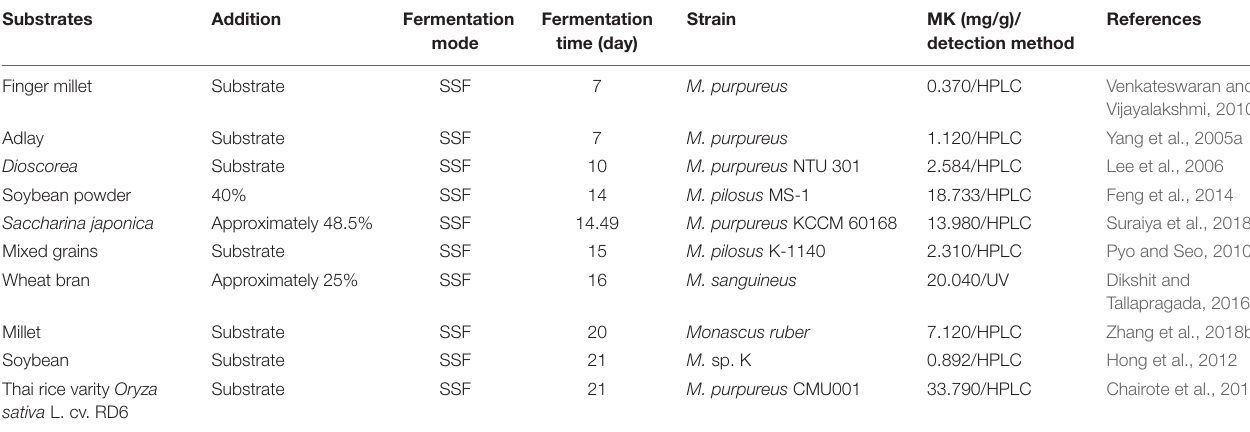
TABLE 1 | Substrates used for FRMR